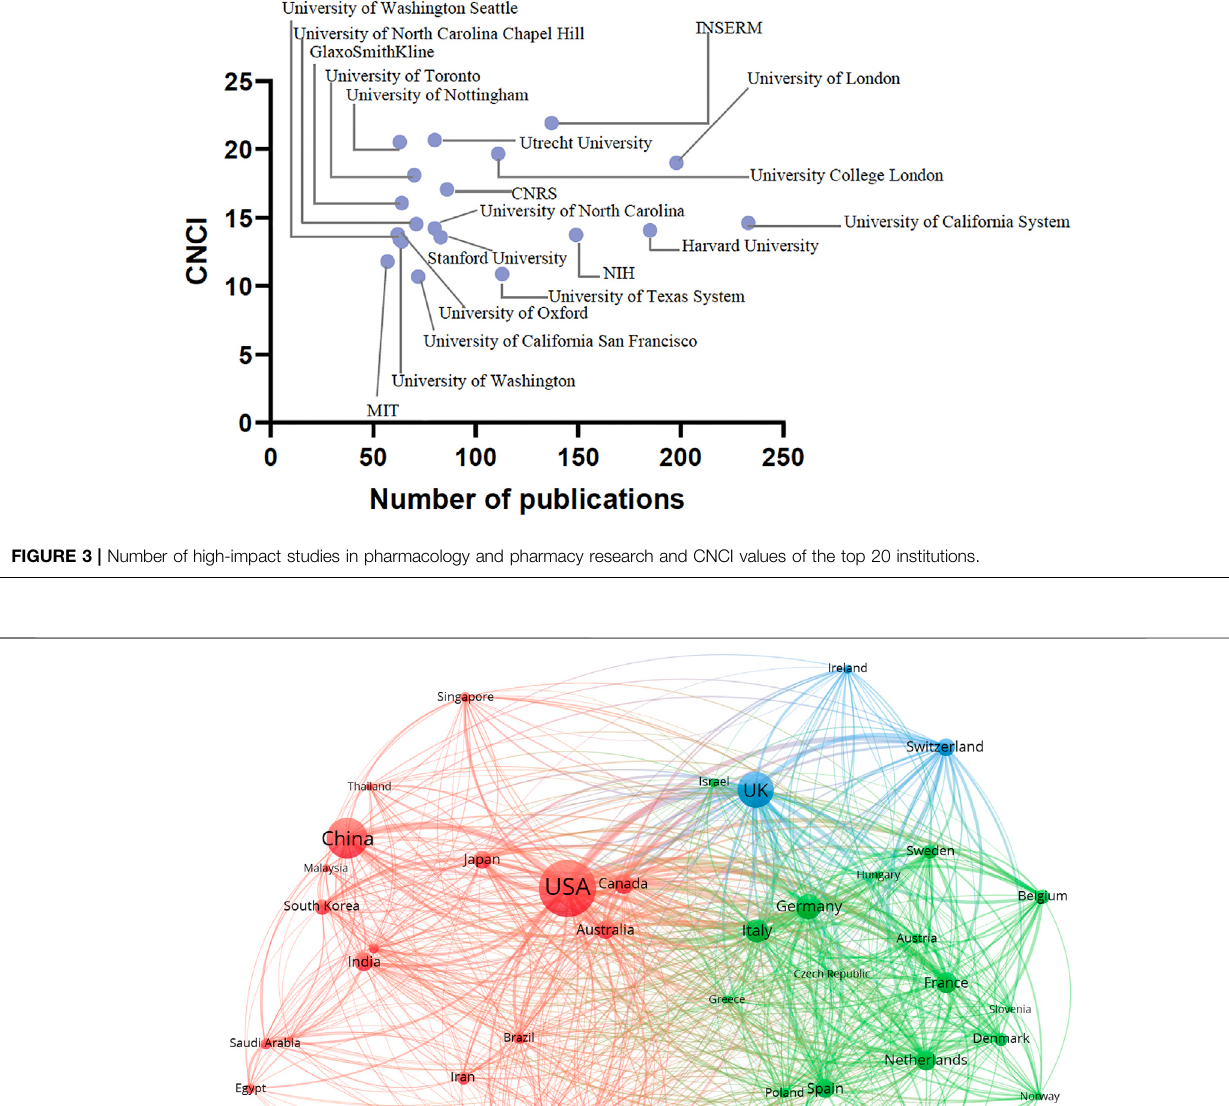
Frontiers in Pharmacology |